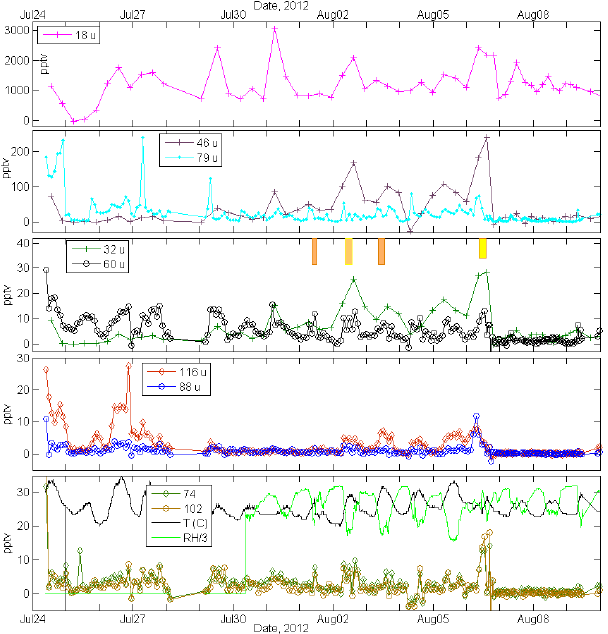
Figure 4. Time series of ammonia (18u, M · H + ) and alkyl amines (32, 46, 60, 74, 88, 102, 116u) in Lewes, DE in the summer of 2012. DMSO abundances (79u) are also shown. Particle formation events are indicated at the top of the 3rd plot with color indicating the intensity (yellow, orange, and dark orange). Temperature ( ◦ C) and relative humidity (%) are also shown in the bottom plot see Supplement Fig. S10a for more ambient data from this campaign.